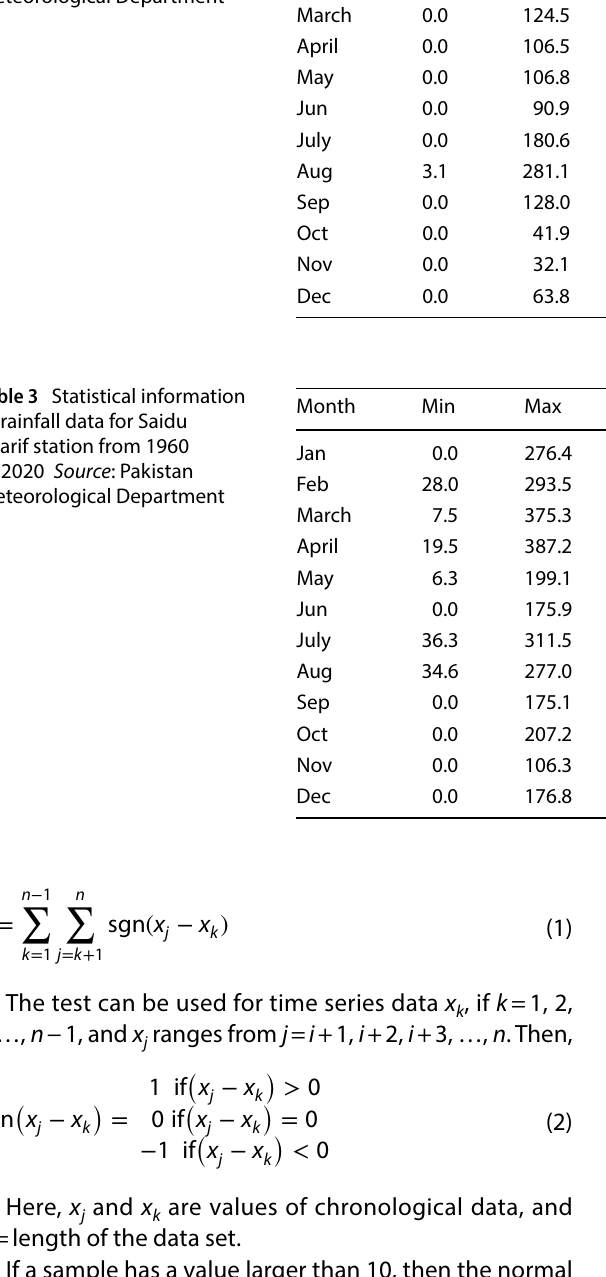
Table 2 Statistical information of rainfall data for Dera Ismail Khan station from 1960 to 2020 Source : Pakistan Meteorological Department